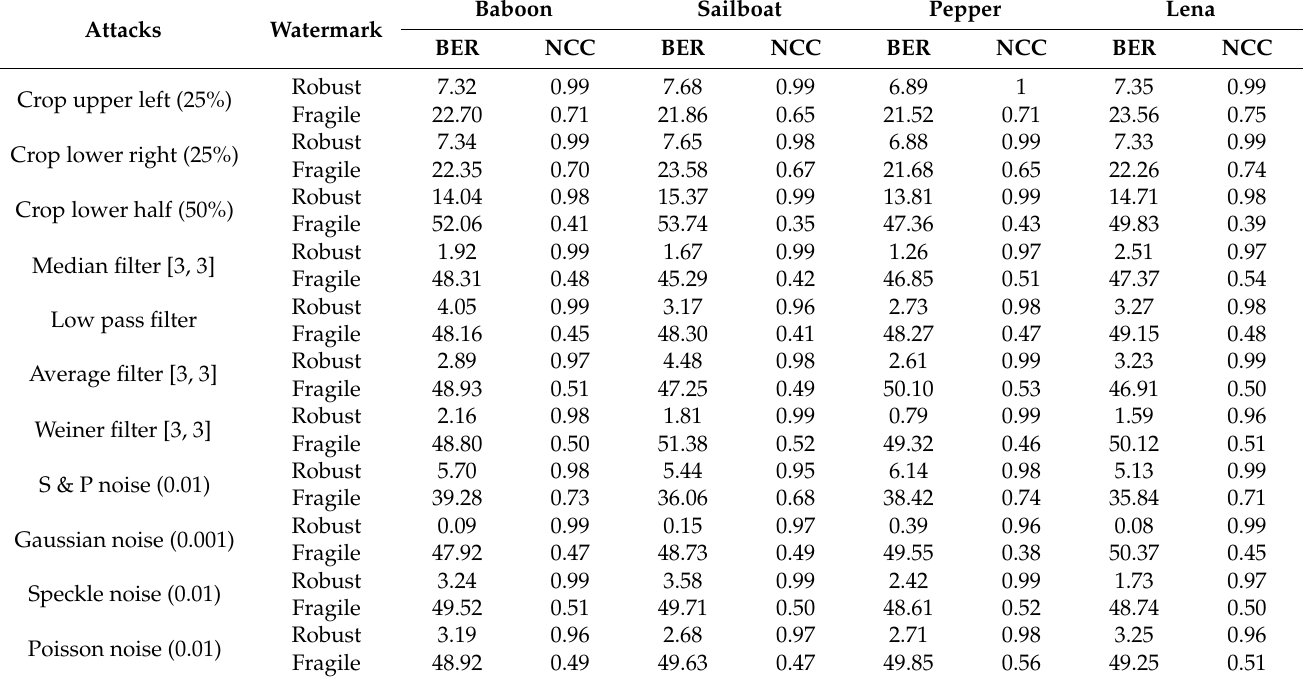
Table 3. Performance test of robust watermark and fragile watermark extracted under single